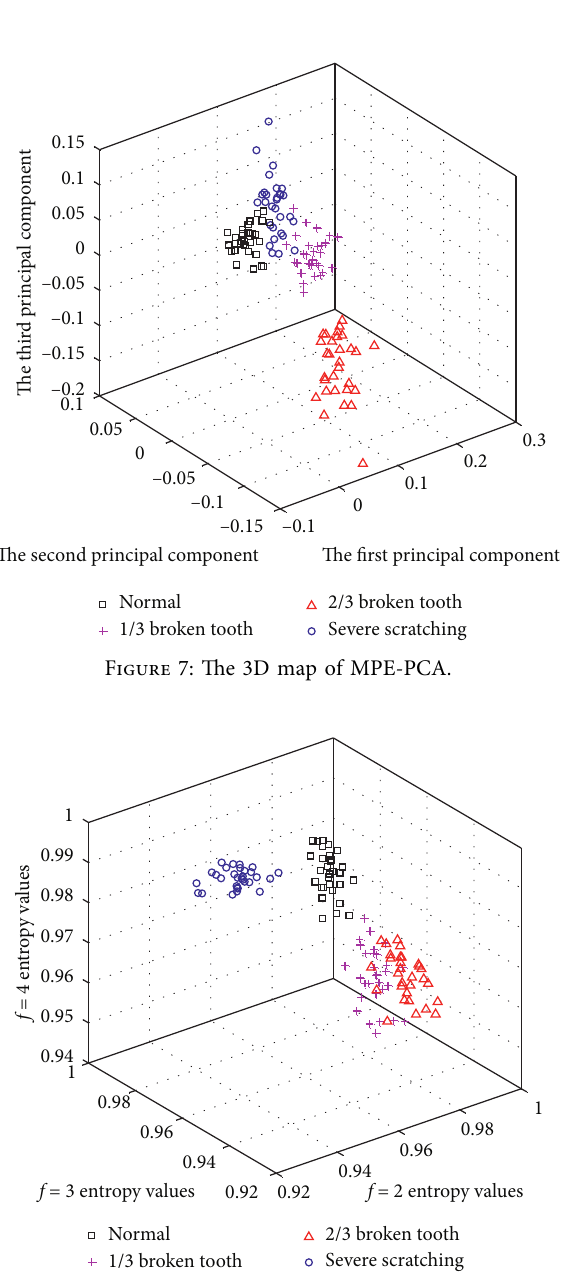
Figure 8: The 3D map of